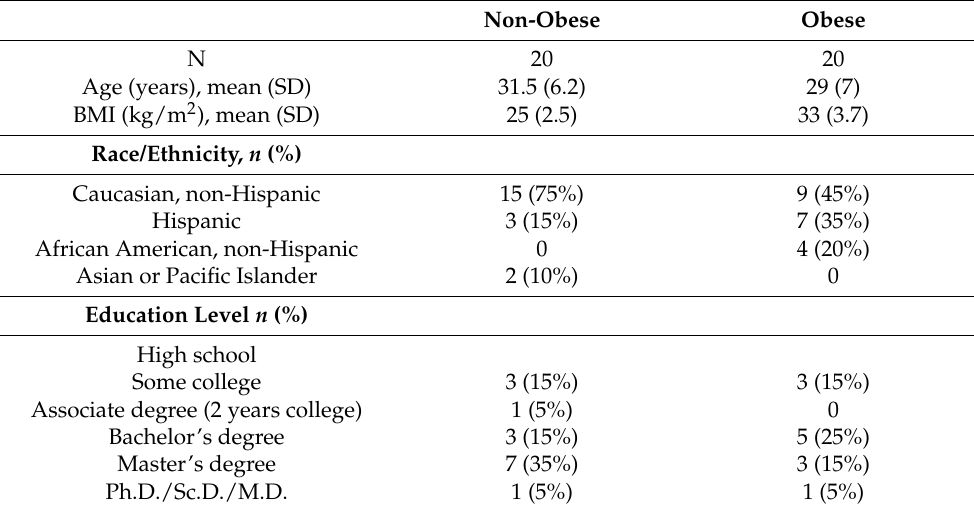
Table 1. Demographics of the study